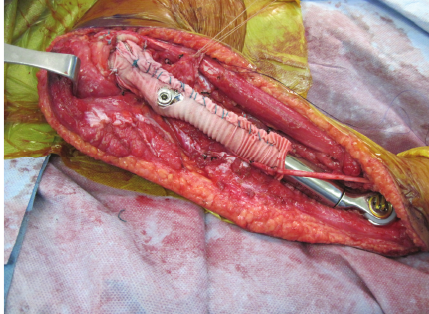
Figure 5: Total humeral surgical specimen and expandable total humeral endoprosthesis.